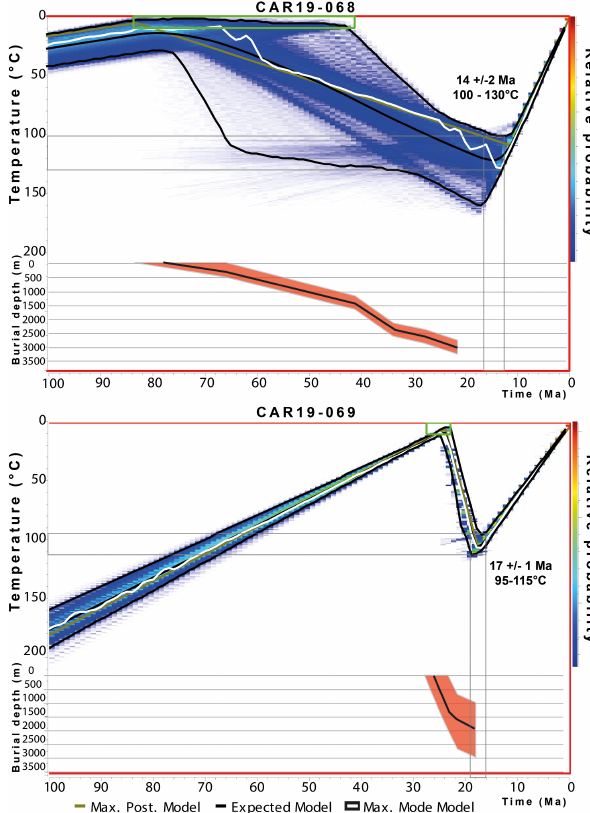
Figure 9. Modeled thermal histories and associated burial diagrams for samples CAR19-045 and CAR19-056 from the Skyba nappe. Peak burial temperature and time are highlighted by grey